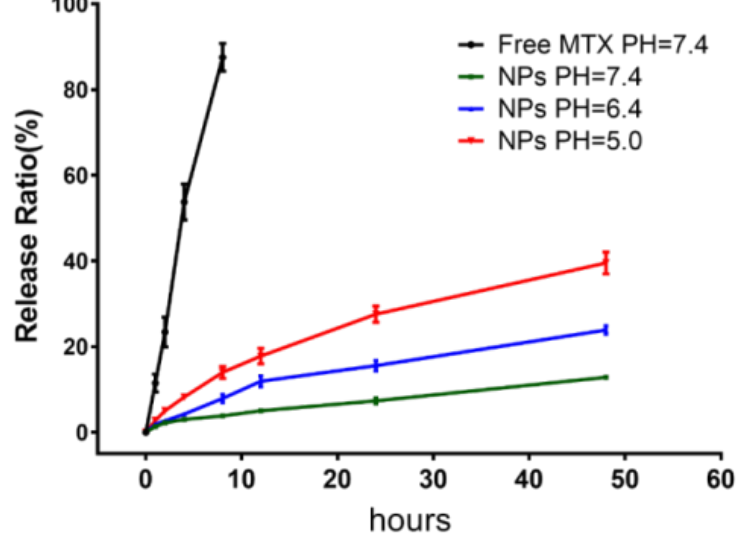
Figure 3. Release curves of free MTX in PBS (pH 7.4) and MTX-PEG-nHA in PBS with three different pH values (5.0, 6.4, 7.4). The data were obtained from three separated experiments, and the bars represent standard errors ( n = 3).